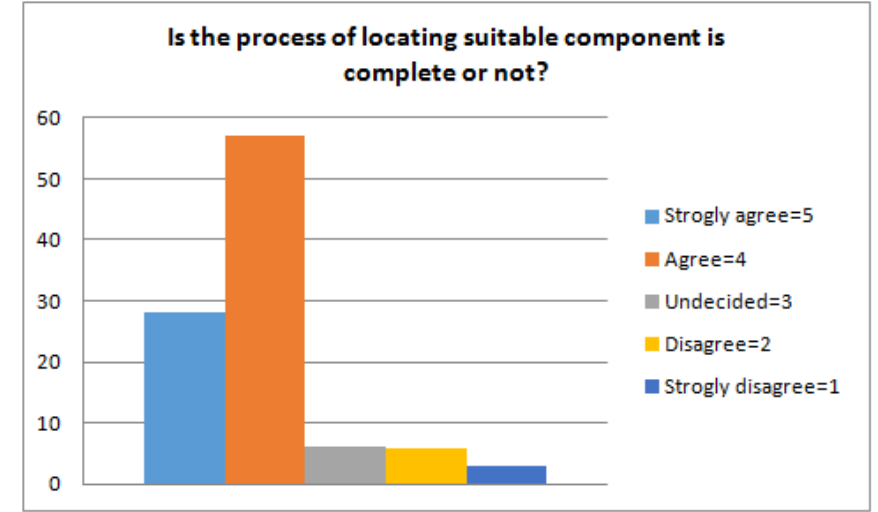
Figure 6. Process completion for retrieving